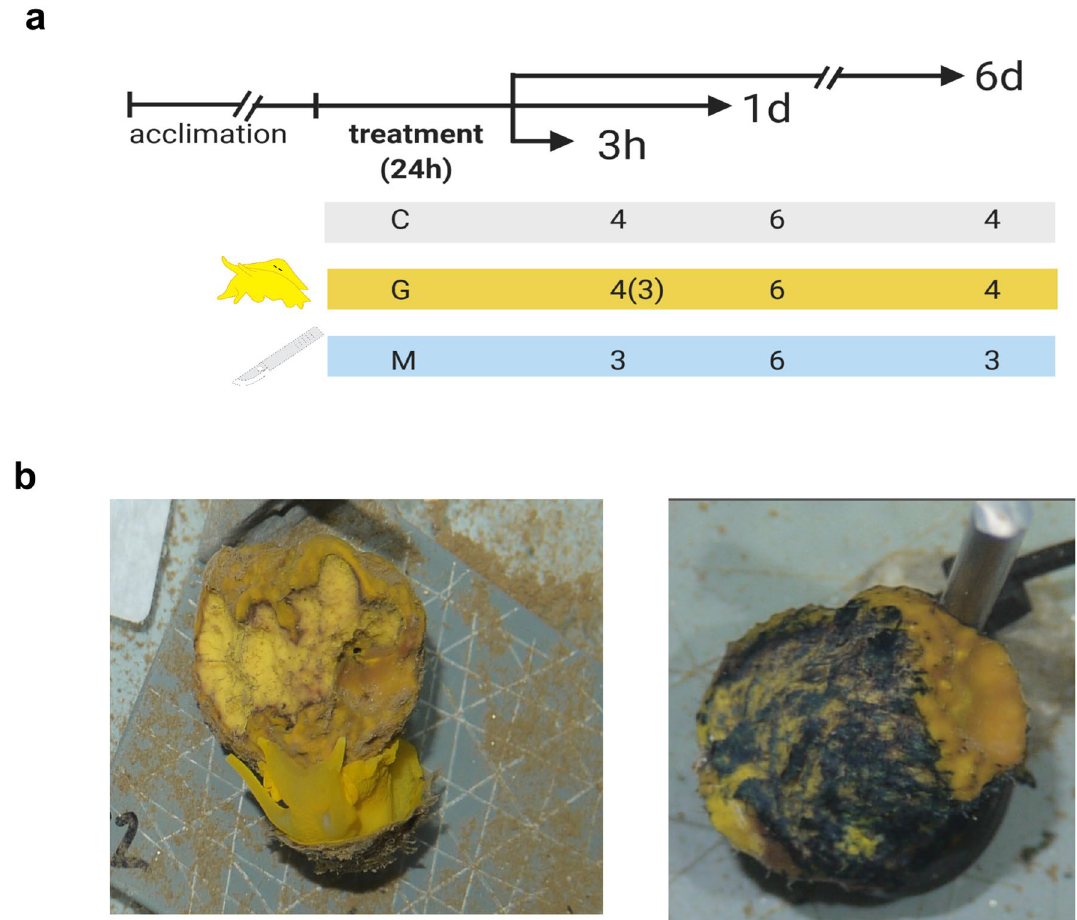
or mechanical damage (M) treatment 40 . Each experiment corresponds to a different time point after stop of treatment: 3 h (3 h); 1 day (1 d) and 6 days (6 d). Number of replicates are shown. One grazed sample collected at 3 h presented low-quality reads and was not included in the differential gene expression analysis. Created with Biorender.com. ( b ) Example of grazed (left) and mechanically-damaged (right)